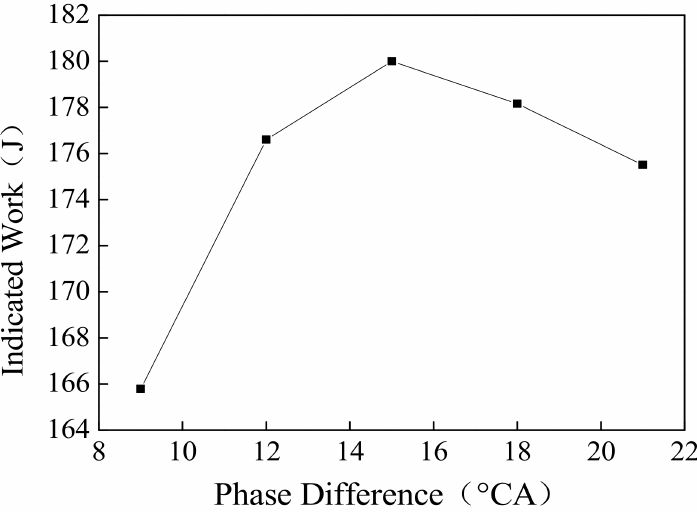
Figure 14. Effect of Phase Difference on Indicated